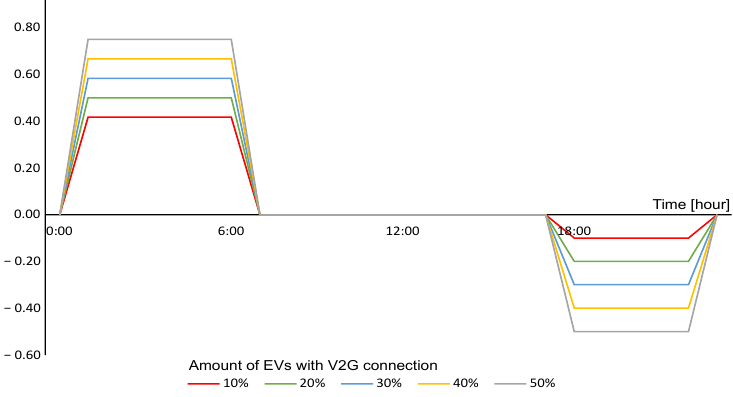
Figure 3. Relative quasi-dynamic V2G load profiles.